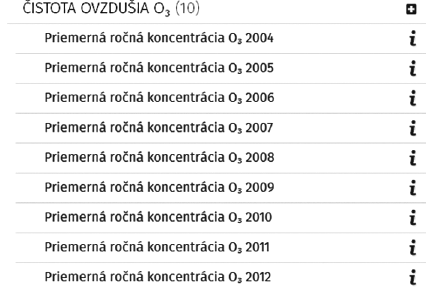
Fig. 3. Time series of S (M,Int) data as available in the AD dropdown menu with available styles for the selected layer: one style per one year and